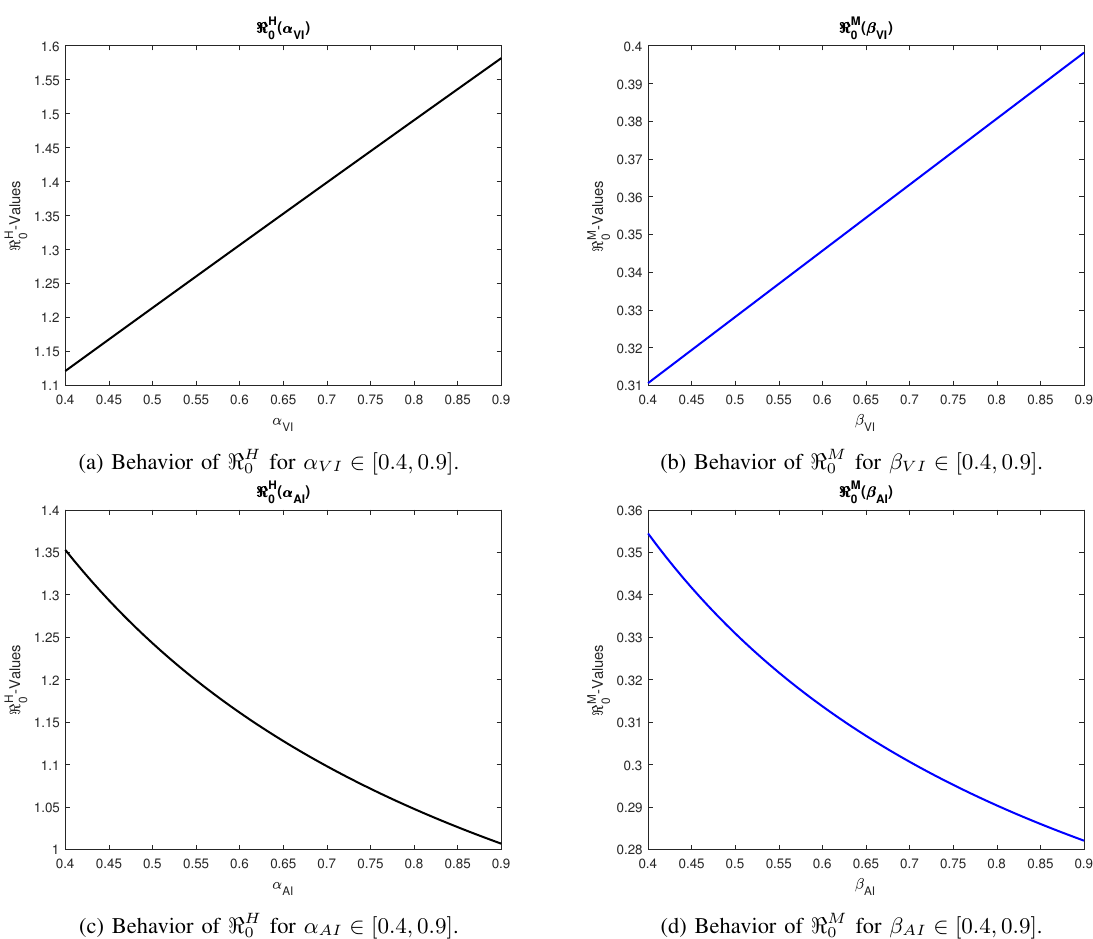
Fig. 5: Behavior of basic reproduction number with respect to parameters associated with undetectability in HIV and